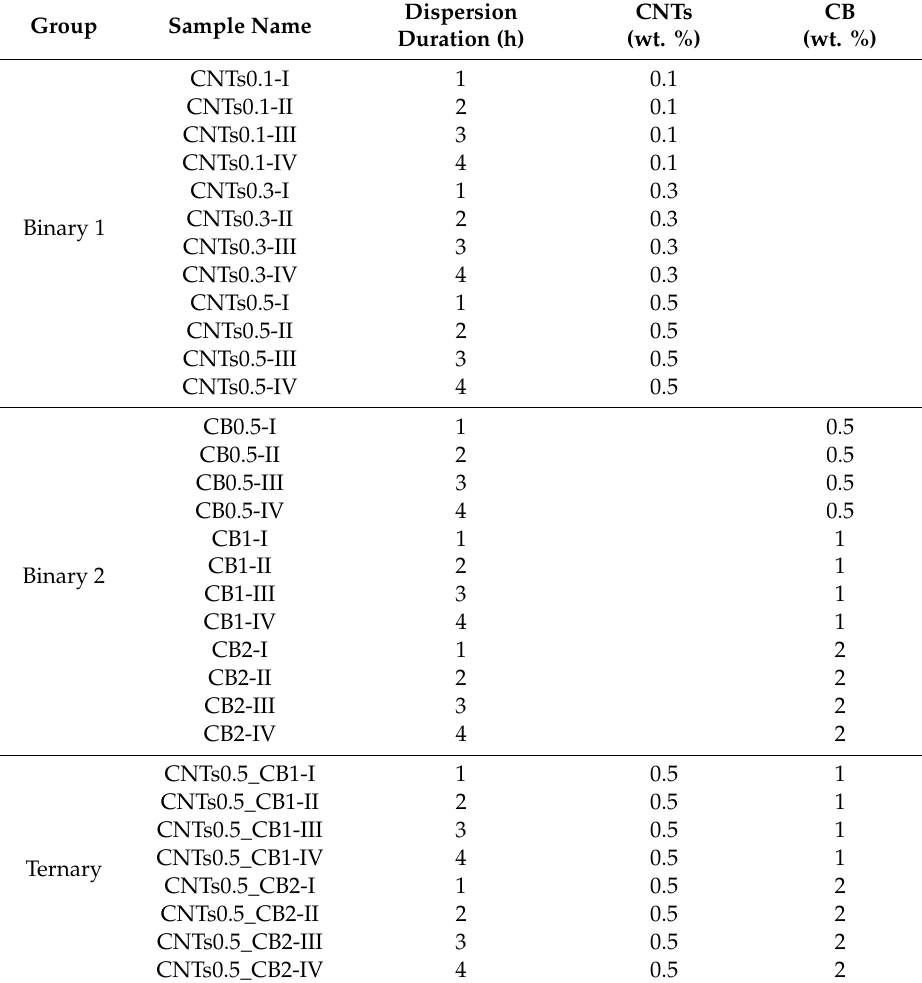
Table 1. Analytical presentation of dispersion